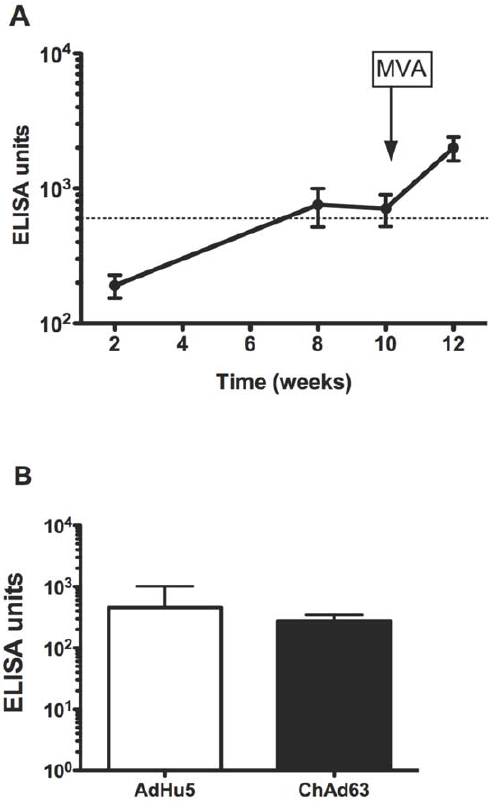
Figure 1. Pfs25 specific total IgG responses following Ad-MVA Pfs25 and ChAd63 Pfs25 immunization. (A) BALB/c mice were immunized with Ad-MVA Pfs25 (AdHu5 Pfs25 prime, MVA Pfs25 boost). Total IgG responses against recombinant Pfs25 protein were